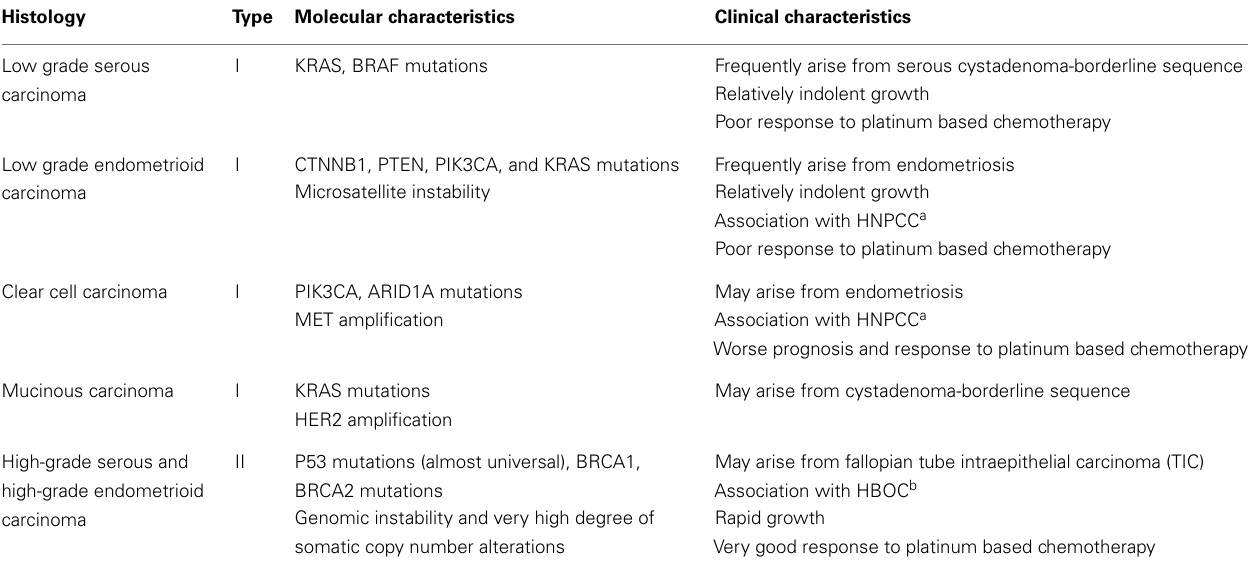
Table 1 | Molecular and clinical characteristics of EOC